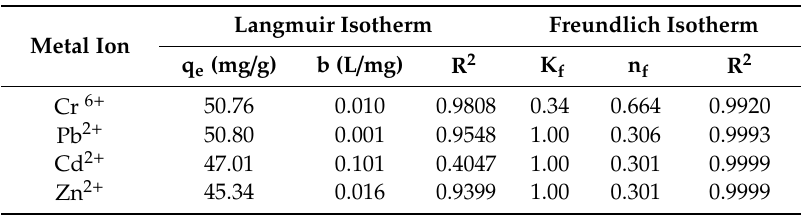
Table 2. The adsorption isotherm data of Langmuir and Freundlich for Cr 6 + , Pb 2 + , Zn 2 + and Cd 2 + on the activated